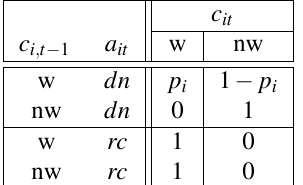
Table 1. Transition probability table for an independent compo- nent